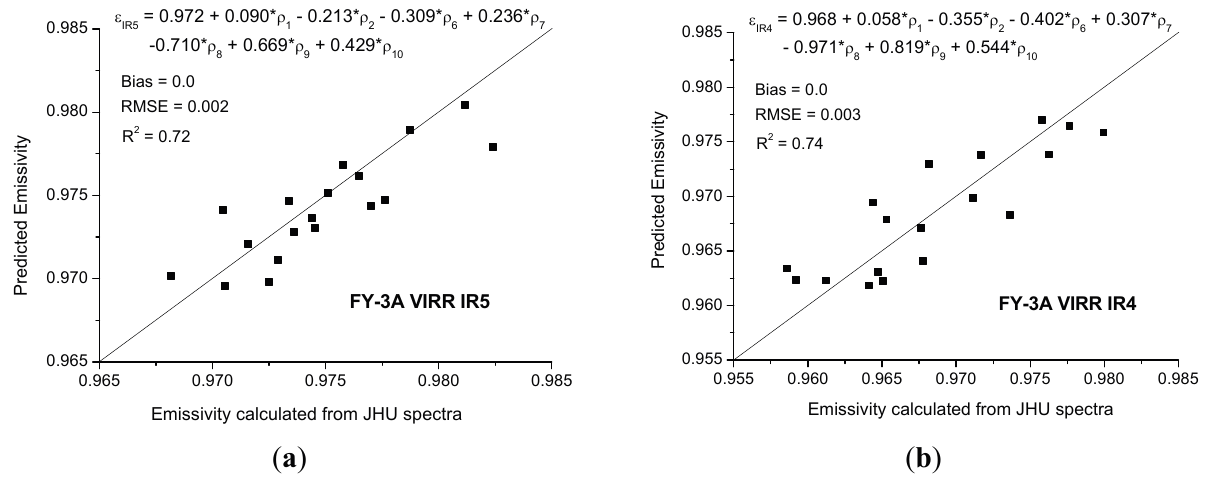
Figure 6. Comparisons of the estimated LSEs and the actual LSEs calculated from the JHU spectra database for different bare soil